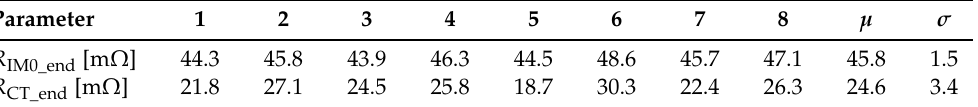
Table 4. R IM0 and R CT of the 8 cells after